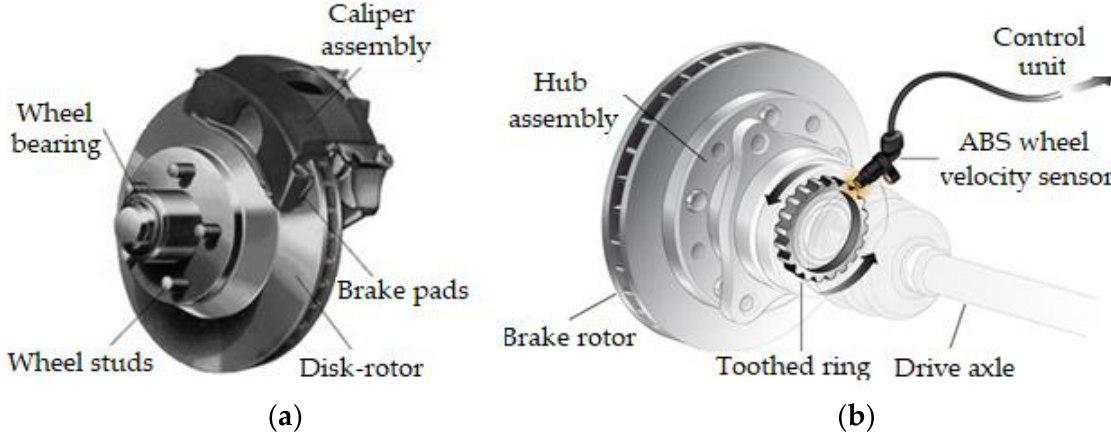
Figure 1. Braking systems; ( a ) pads with disk; ( b ) Antilock Braking System (ABS).